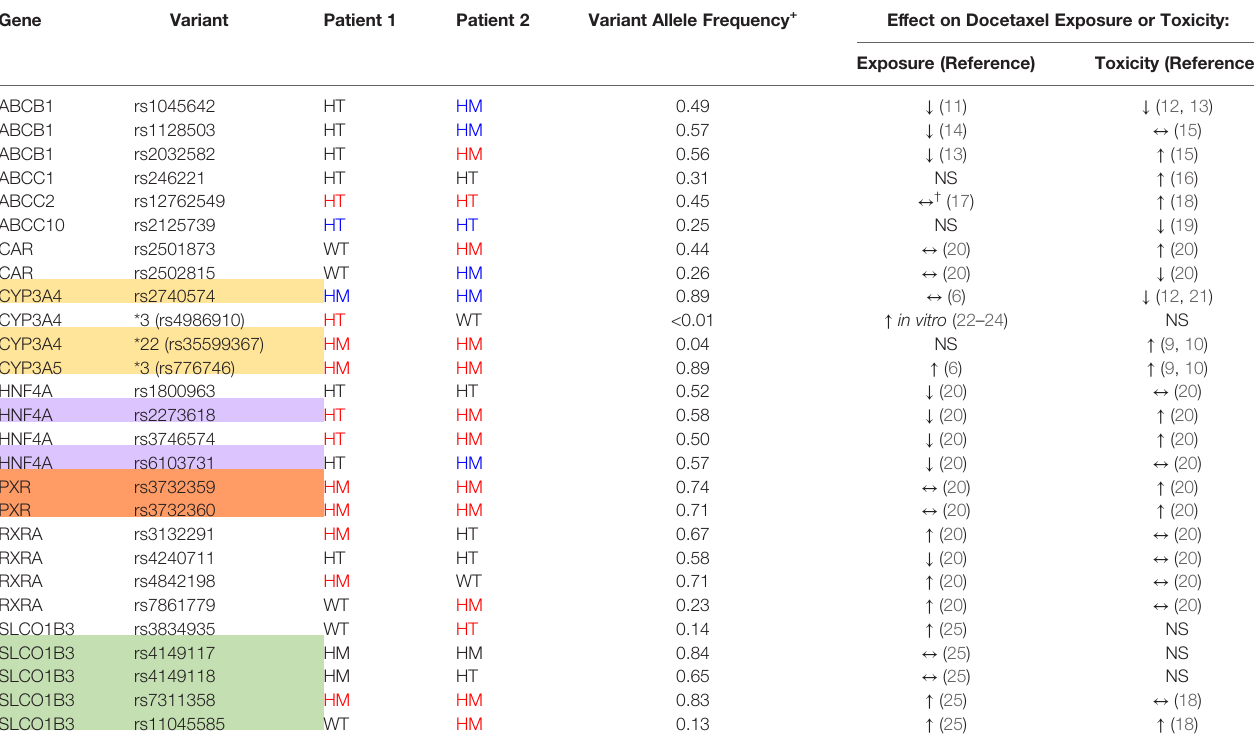
TABLE 1 | Patient status for genetic variants in docetaxel pharmacokinetics-related genes that have previously been associated with exposure or toxicity. Gene Variant Variant Allele Frequency + Effect on Docetaxel Exposure or